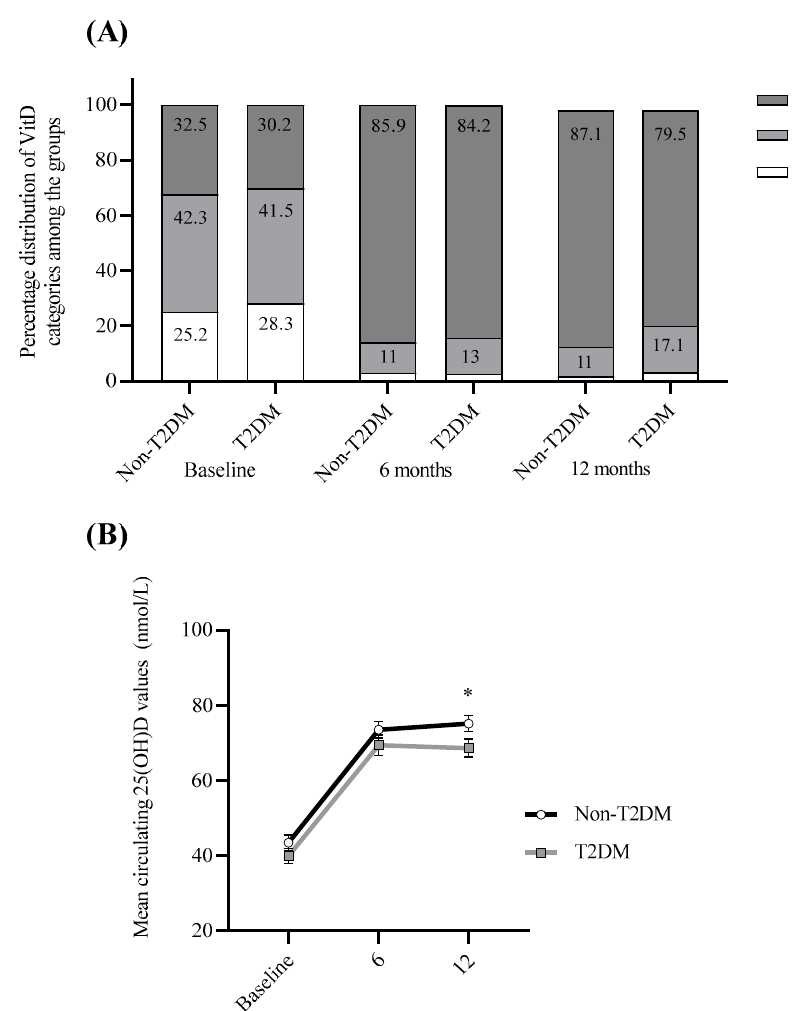
Figure 3. Summary of circulating 25(OH)D improvements. ( A ) Percentage distribution of T2DM and non-T2DM participants with deficient (<25 nmol/L), insufficient (25–50 nmol/L) and sufficient (>50 nmol/L) circulating 25(OH)D levels at baseline, 6-months and 12-months post-surgery for T2DM and non-T2DM groups. ( B ) Mean circulating 25(OH)D values at baseline, 6-months and 12-months post-surgery for T2DM and non-T2DM groups. Statistical differences between non-T2DM and T2DM cohorts were analyzed using 2-tailed independent samples t -test. * p < 0.05